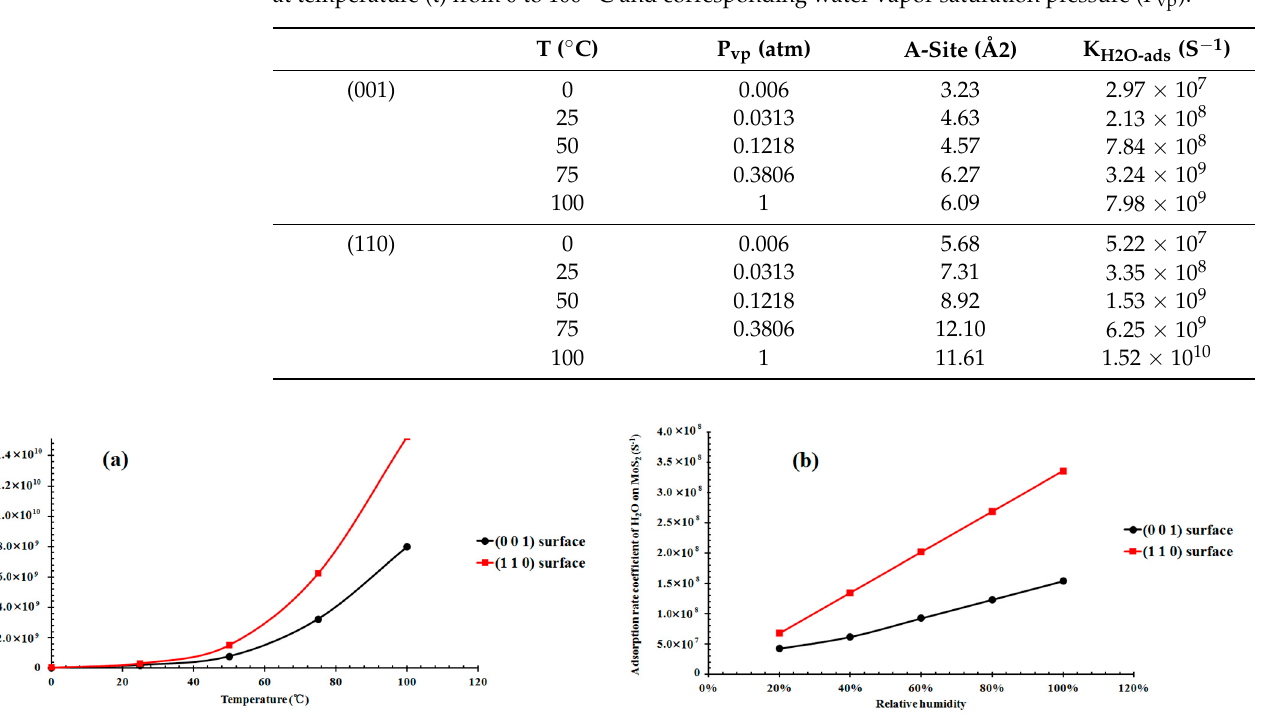
Table 2. Adsorption rate coefficient of H 2 O (K H2O-ads ) on the (001) and (110) surfaces of molybdenite